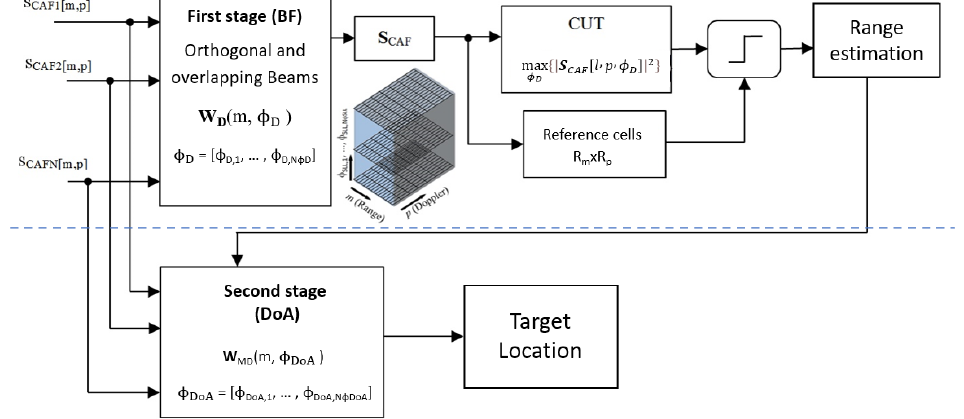
Figure 3. Proposed two-stage frequency-domain spatial filtering